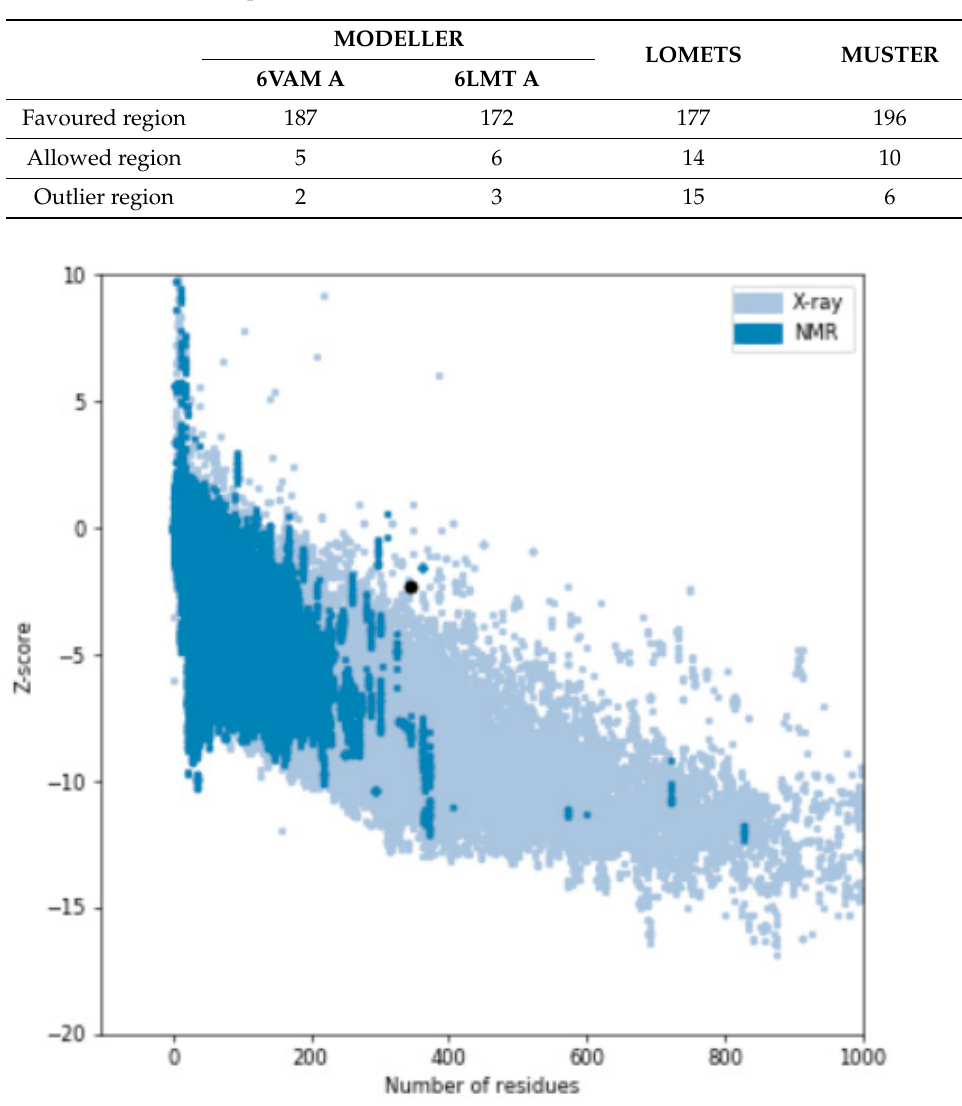
Figure 10. Quality of the protein structure (ProSA Server).